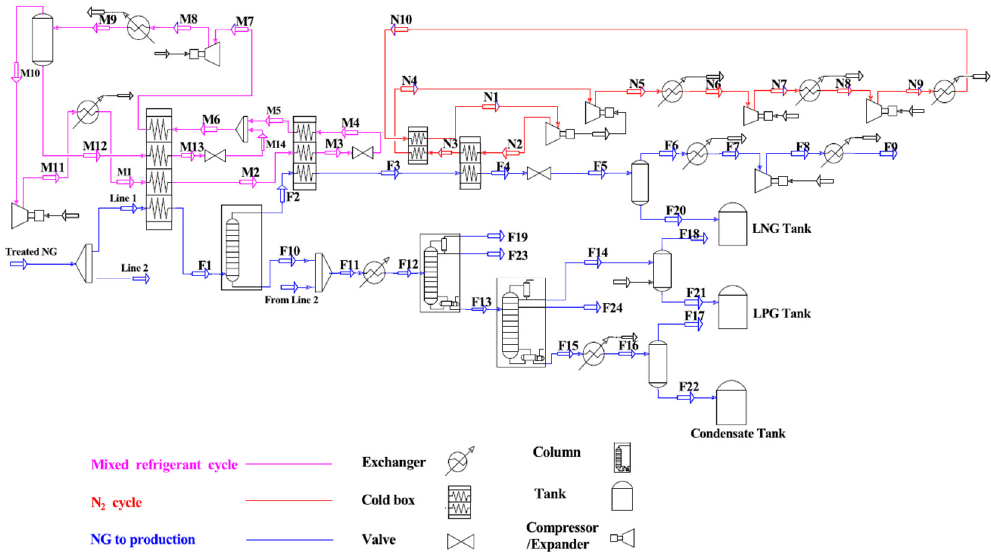
Figure 23. Mixed refrigerant pre-cooling nitrogen expander process [74]. Reproduced with permis- sion from Elsevier (license number